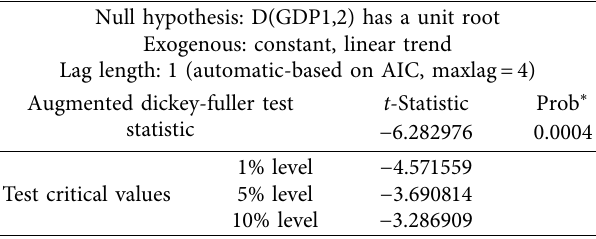
Table 3: Stationarity test results of China’s GDP data from 1998 to 2019.